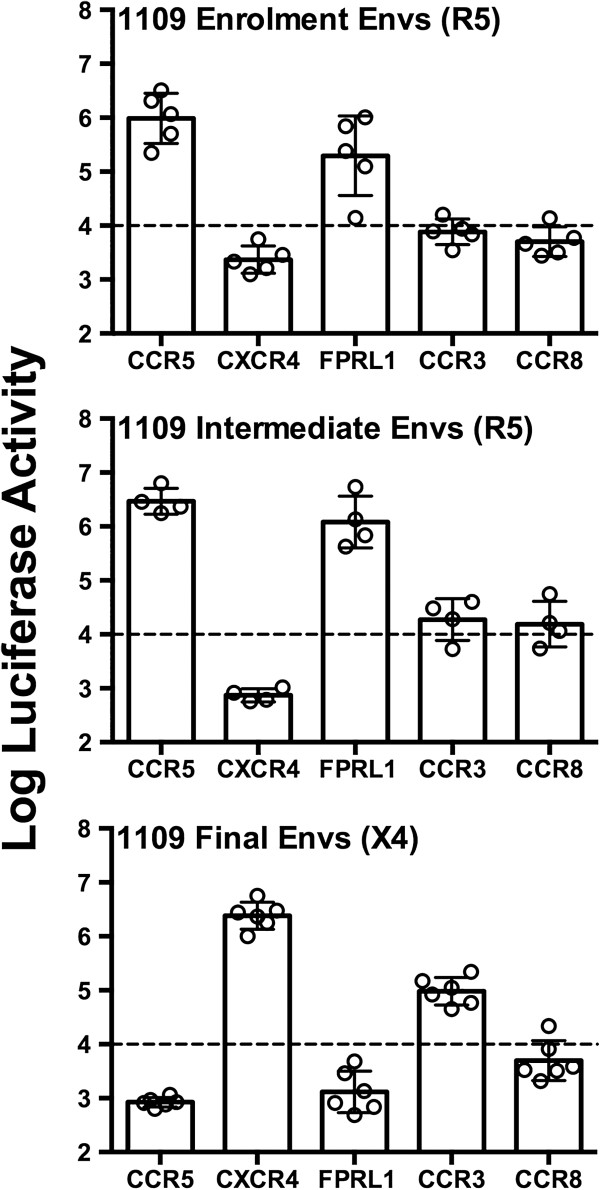
Changes in alternative coreceptor usage during the transition from R5 to X4 phenotype in subject 1109. Luciferase reporter viruses pseudotyped with “enrolment” (R5, n = 5), “intermediate” (R5, n = 4) or “final” (X4, n = 6) Envs from subject 1109 [8] were used to infect NP2-CD4 cells expressing CXCR4, CCR5, FPRL1, CCR3 or CCR8, and the levels of HIV-1 entry were determined as described in the Methods. The dotted lines indicate the limit of detection of coreceptor activity, as determined by infections with luciferase reporter virus pseudotyped with the non-functional ΔKS Env [44]. Comparative entry levels for each of the individual Envs are shown in Additional file 1: Table S1. The data shown are means and standard deviations of entry levels in the different cell types, and are representative of 3 independent experiments, each performed in triplicate. The individual circles represent mean entry levels of each of the individual Env clones that were performed in triplicate, from a representative experiment.